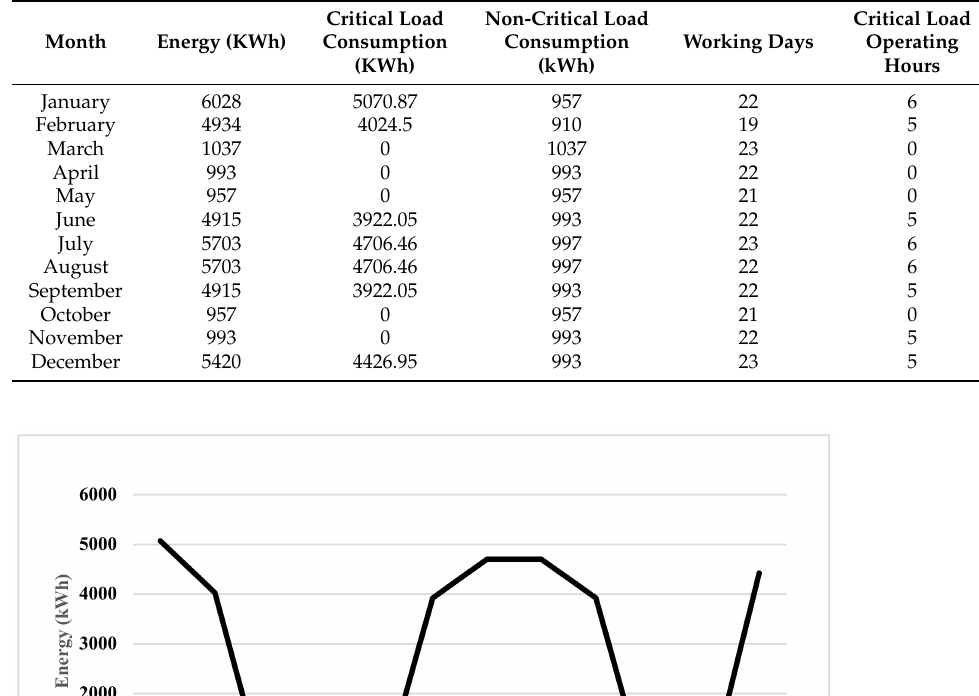
Table 2. Monthly consumption of the building’s loads (2021).